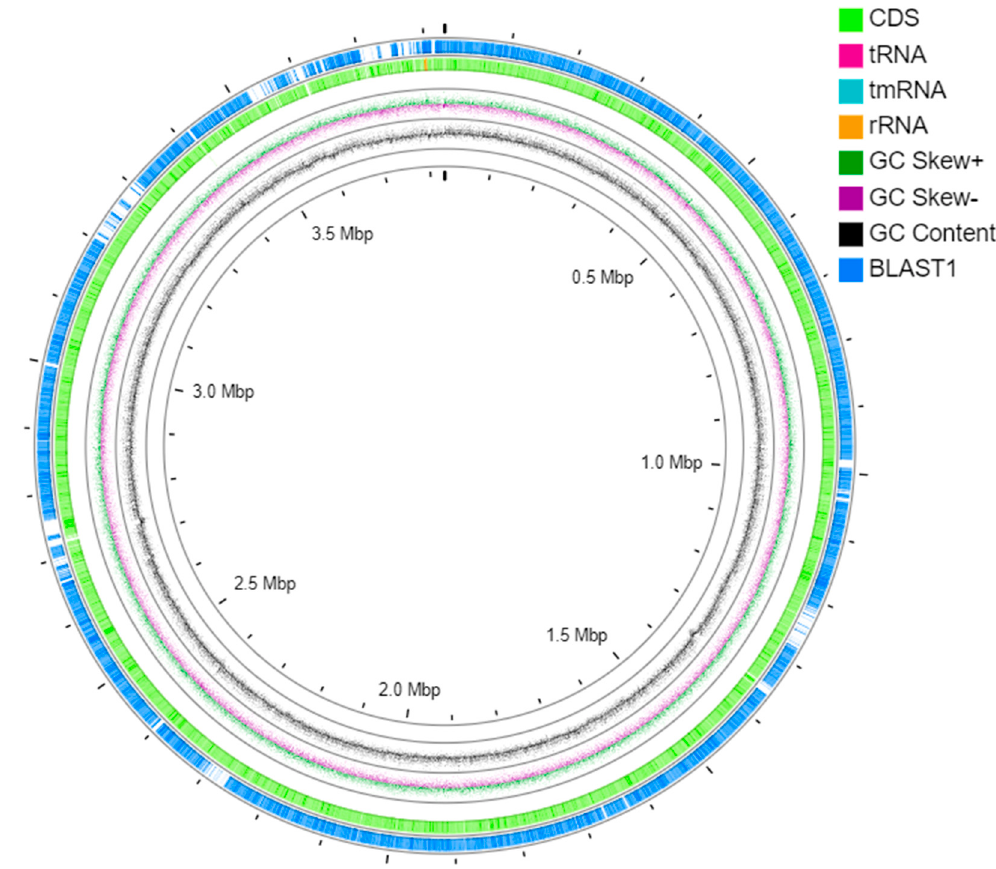
Figure 5. The circular view of the genome D. psychralcaliphila JI1D using CGViewer. Table 2. Contents of the annotated genome.